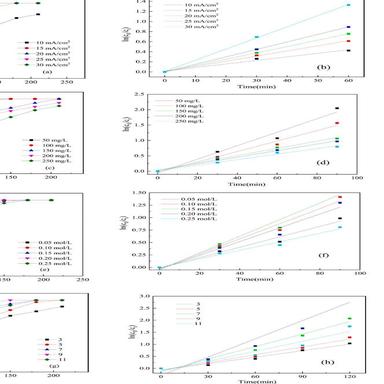
The effect of different current densities on the degradation of phenol (a) and the kinetic curve fitting (b); The effect of different initial concentrations of phenol on degradation (c) and kinetic curve fitting (d); The effect of different electrolyte concentrations on the degradation of phenol (e) and the kinetic curve fitting (f); The effect of different initial pH values on phenol degradation (g) and kinetic curve fitting (h).